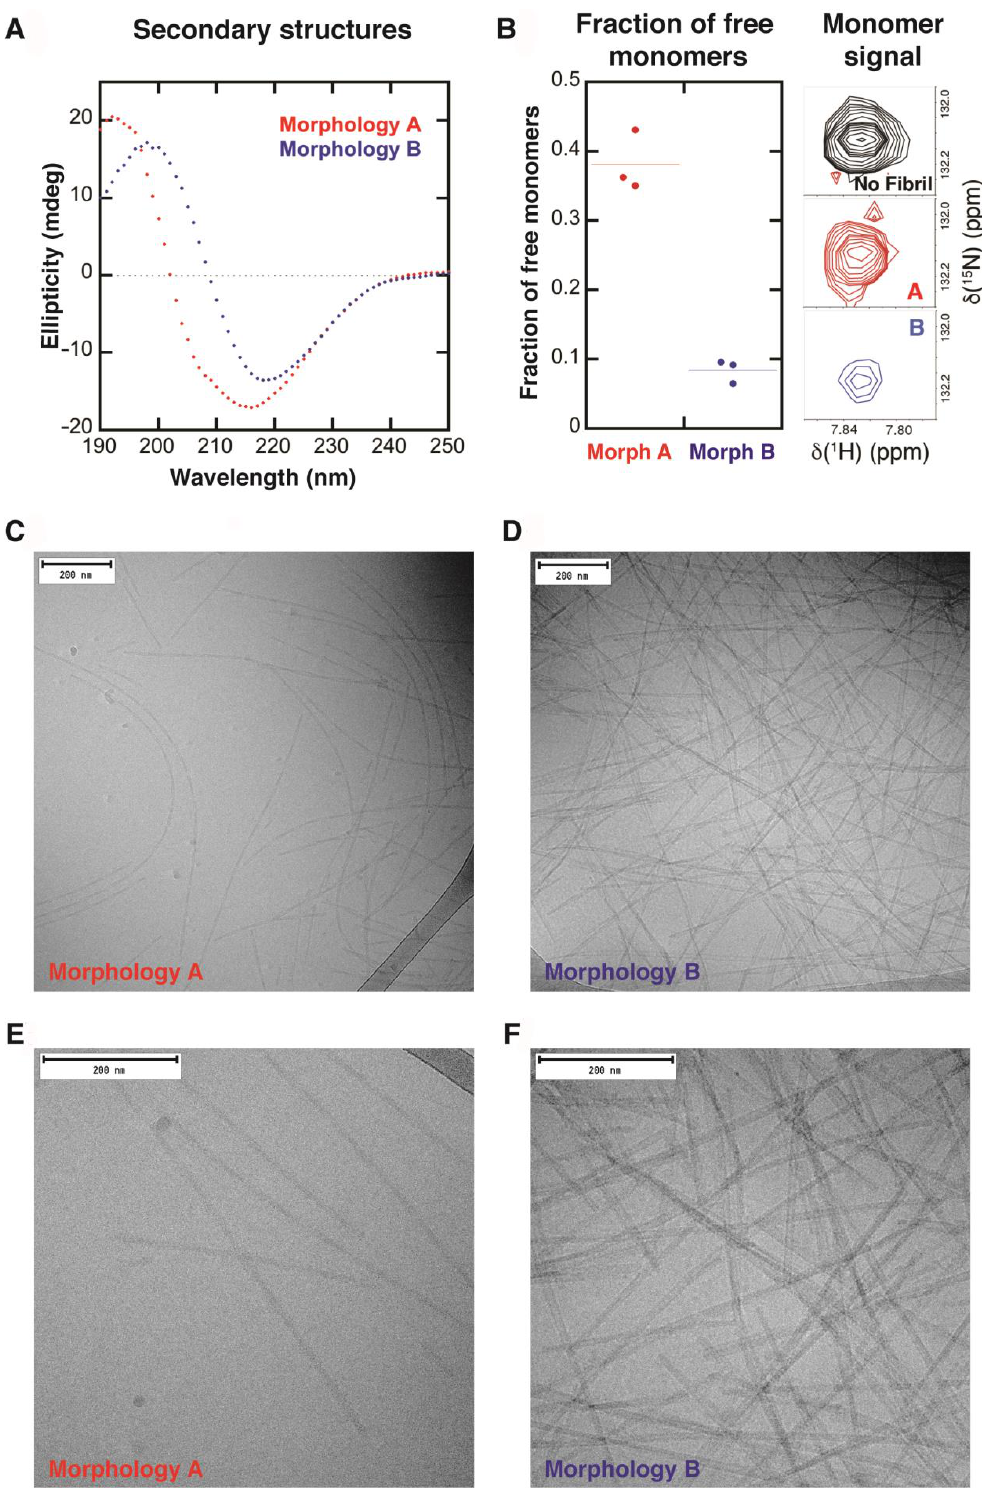
Figure 2. Two different fibril morphologies, A and B, observed in two different samples originating from the same monomer preparation (10 mM Tris, 0.02% NaN 3 , 5% D 2 O, pH 7). ( A ) CD spectra in the secondary structure region for the two different morphologies. ( B ) Left : Fraction of free monomers measured by NMR spectroscopy by comparing the relative integrated intensity of A140 in the fibrillar samples relative to that of the monomeric sample. The data are visualized with a dot-plot, where each data point is represented with a dot and the average with a dashed line. Right : Comparison